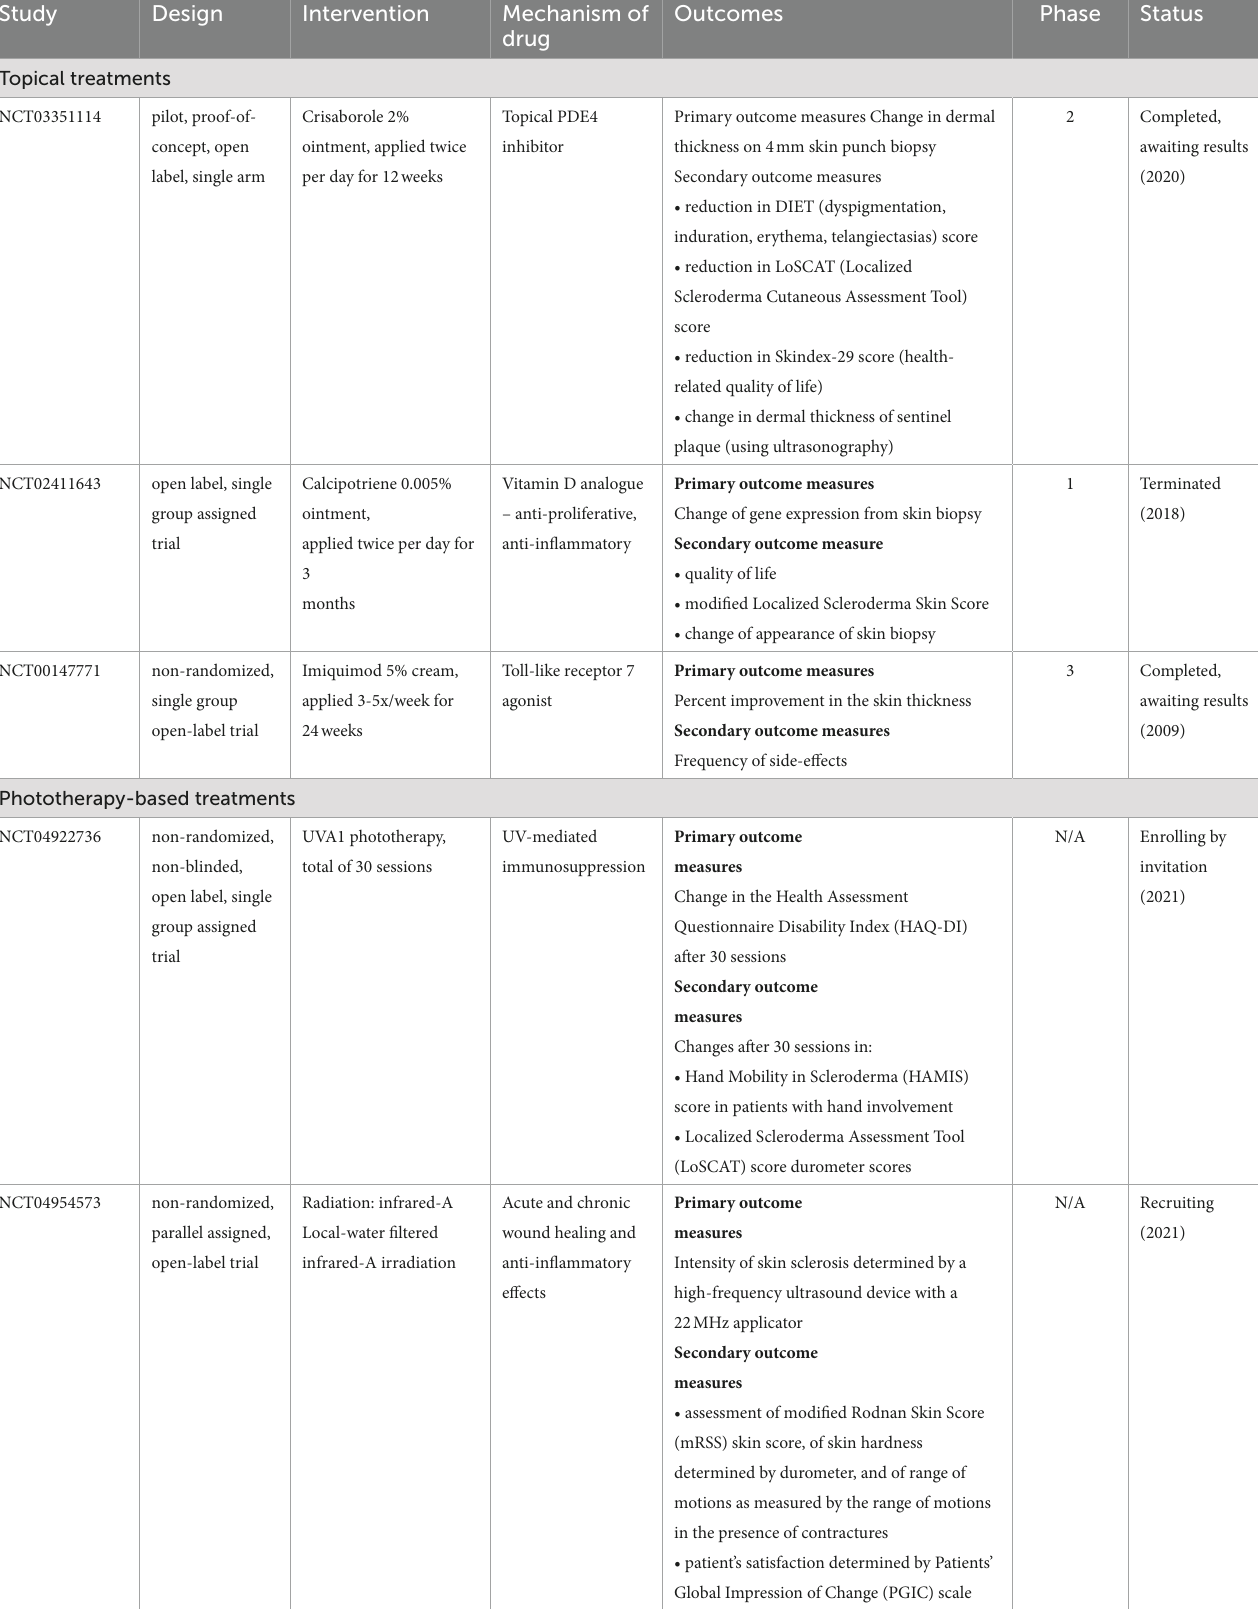
TABLE 3 Clinical trials in morphea.